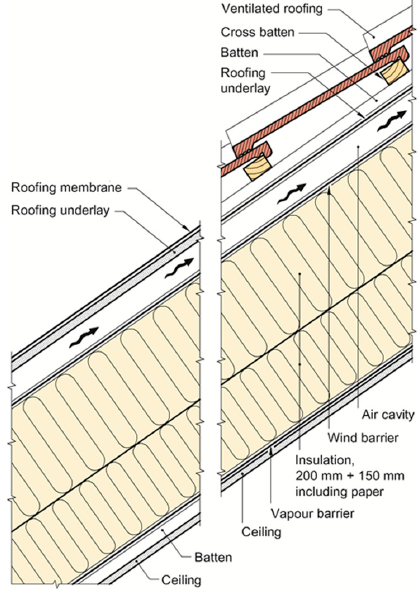
Figure 1. Roof Type A, which separates the rain and wind barrier [13]. Here shown with two common types of roofing.